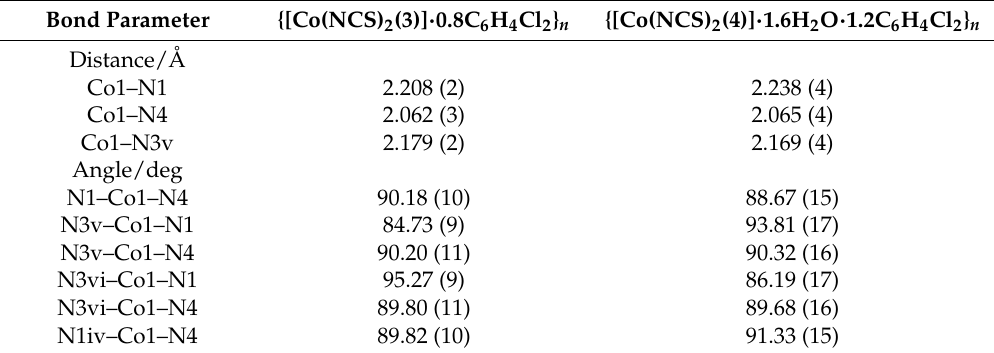
Figure 3. The asymmetric unit in {[Co(NCS) 2 ( 4 )] · 1.6H 2 O · 1.2C 6 H 4 Cl 2 } n and symmetry-generated atoms to show ligand 4 as a 4-connecting node. Symmetry codes: i = − 1 − x , 2 − y , 1 − z ; ii = − 1 + x , 1 + y , z ; iii = − 1 − x , 1 / 2 + y , 1 / 2 − z ; iv = − x , 1 − y , 1 − z ; v = − x , − 1 / 2 + y , 3 / 2 − z ; vi = x , 3 / 2 − y , − 1 / 2 + z ; vii = − x , 1 / 2 + y , 3 / 2 − z . Table 1. Important bond parameters in {[Co(NCS) 2 ( 3 )] · 0.8C 6 H 4 Cl 2 } n and {[Co(NCS) 2 ( 4 )] · 1.6H 2 O · 1.2C 6 H 4 Cl 2 } n